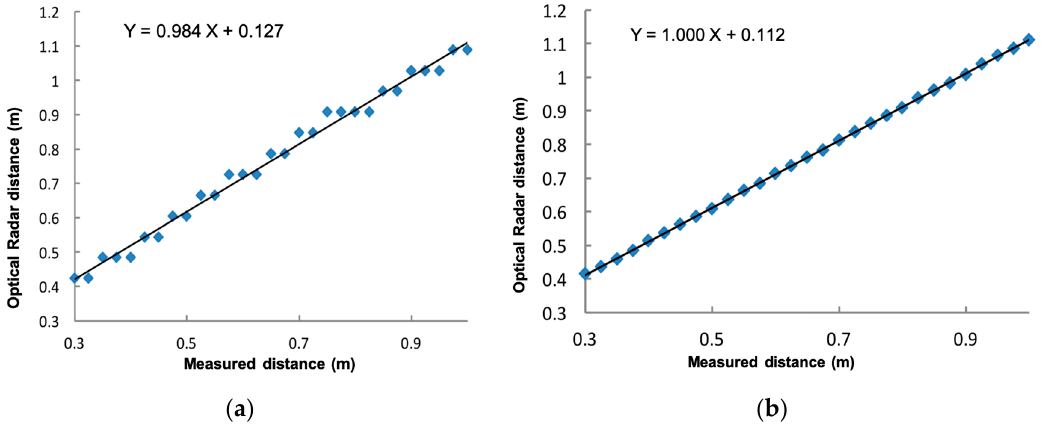
Figure 3. Radar offset determination. ( a ) Results with Tr = 4 ms and padding = 1, showing an apparent stepped sampling effect; ( b ) Results with optimized processing, improving linearity and giving an offset of 11.2 cm.